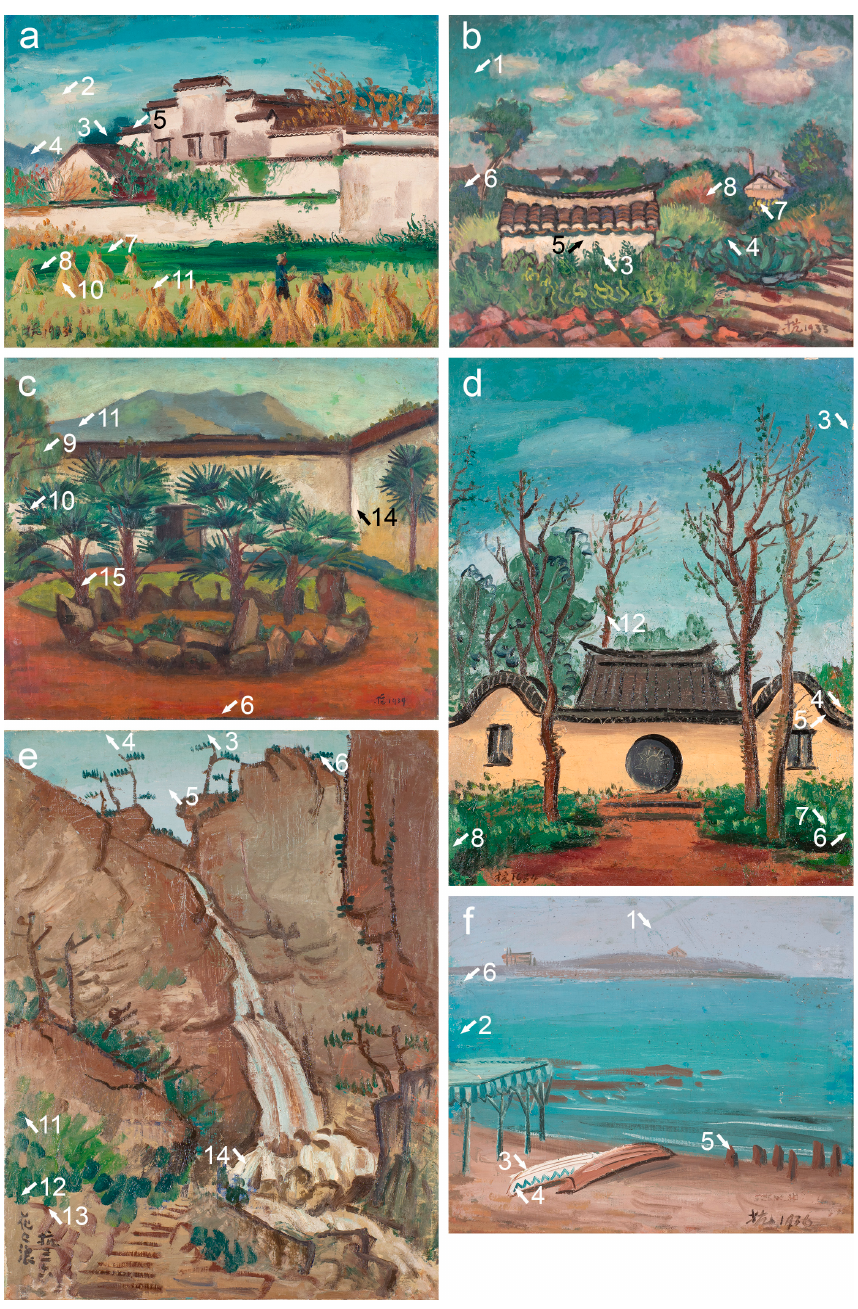
Figure 2. Paintings by Liu Kang from the collection of the National Gallery Singapore. ( a ) Working at the fields , 1933, oil on canvas, 49.5 × 64 cm; ( b ) Countryside in China , 1933, oil on canvas, 60.5 × 72 cm; ( c ) Backyard , 1934, oil on canvas, 59.5 × 72.5 cm; ( d ) Chinese house , 1934, oil on canvas, 64.5 × 50.5 cm; ( e ) Waterfall , 1936, oil on canvas, 65 × 50 cm; ( f ) Seaside , 1936, oil on canvas, 45 × 54 cm. Gifts of the artist’s family. Collection of the National Gallery Singapore. Images courtesy of the National Heritage Board, Singapore. Arrows indicate sampling areas.